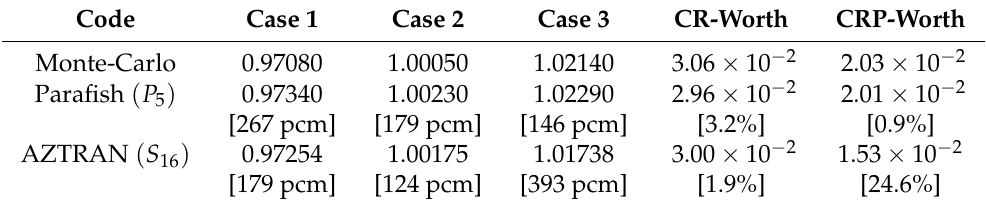
Table 3. Comparison of k ef f and control rod worth for Axially heterogeneous FBR